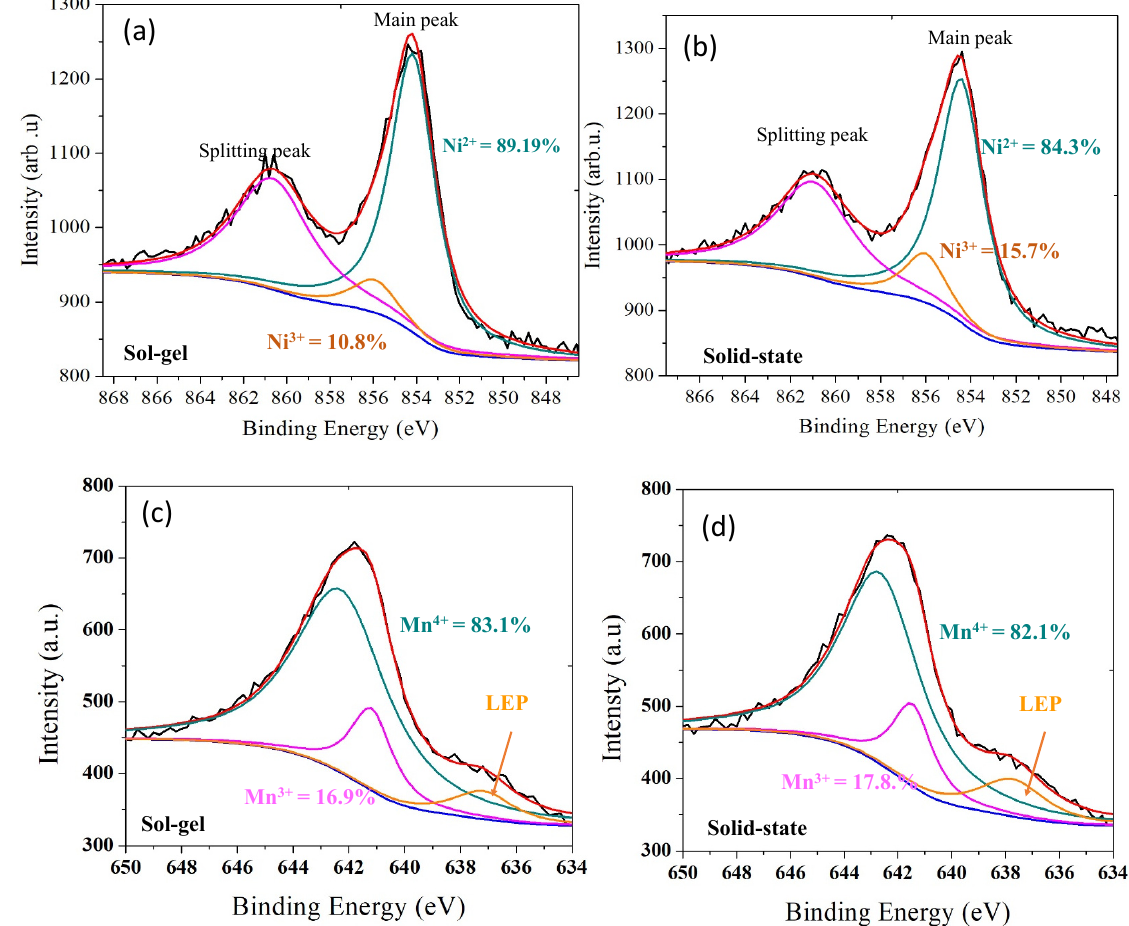
Figure 4. XPS spectra for the Ni2p 3/2 photoemission line of the layered LiNi 0.5 Mn 0.5 O 2 sample ( a ) Sol-gel and ( b ) Solid state. The Mn2p 3/2 photoemission line of the layered LiNi 0.5 Mn 0.5 O 2 sample ( c ). Sol-gel and ( d ). Solid state.